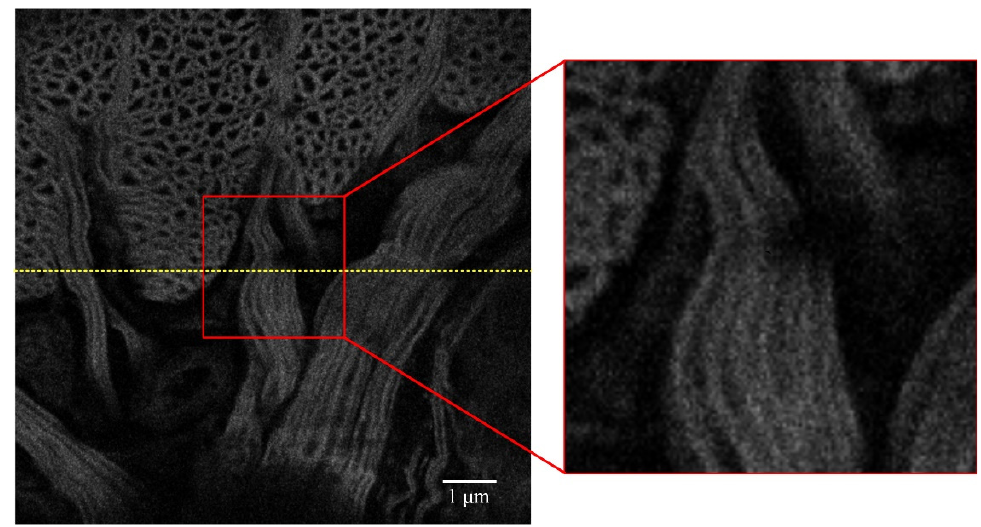
Figure 6. Imaging result after correction with 100 iterations of the fixed coefficient SPGD algorithm, and the grayscale variance value is about 8.9.